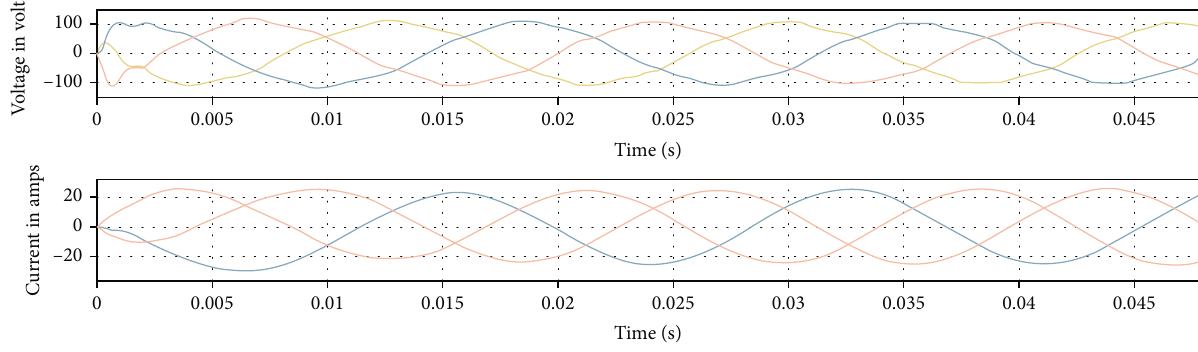
Figure 13: Voltage and current waveform of a photovoltaic